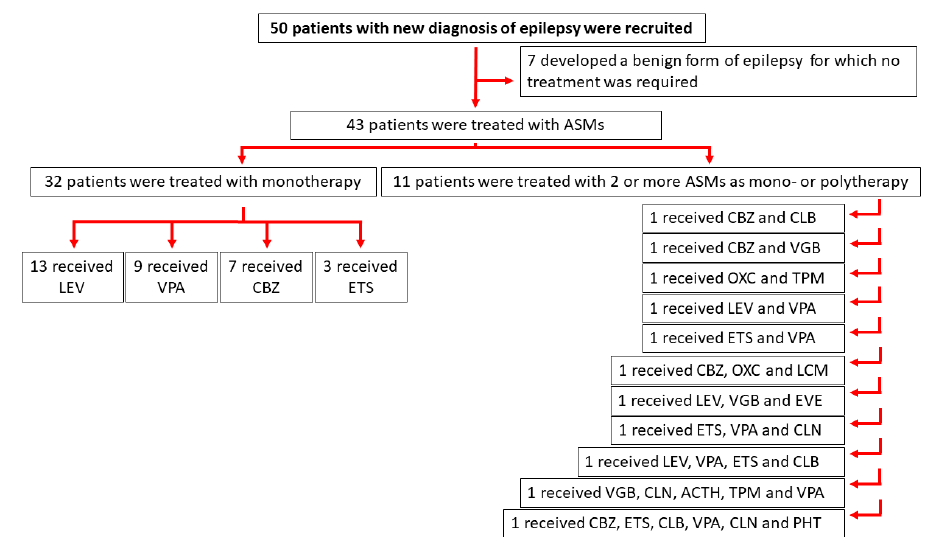
Figure 1. Flowchart illustrating the patients’ enrolment and treatment subsequent to diagnosis of epilepsy. Antiseizure medications (ASMs) were provided for therapeutic reasons by the pediatrician in charge. Precisely: (i) first generation of ASMs included adrenocorticotropic hormone (ACTH), carbamazepine (CBZ), clonazepam (CLN), ethosuximide (ETS), phenytoin (PHT), valproic acid (VPA); (ii) second generation of ASMs included levetiracetam (LEV), oxcarbazepine (OXC), topiramate (TPM), and vigabatrin (VGB); (iii) third generation of ASMs included clobazam (CLB), everolimus (EVE), and lacosamide (LCM).